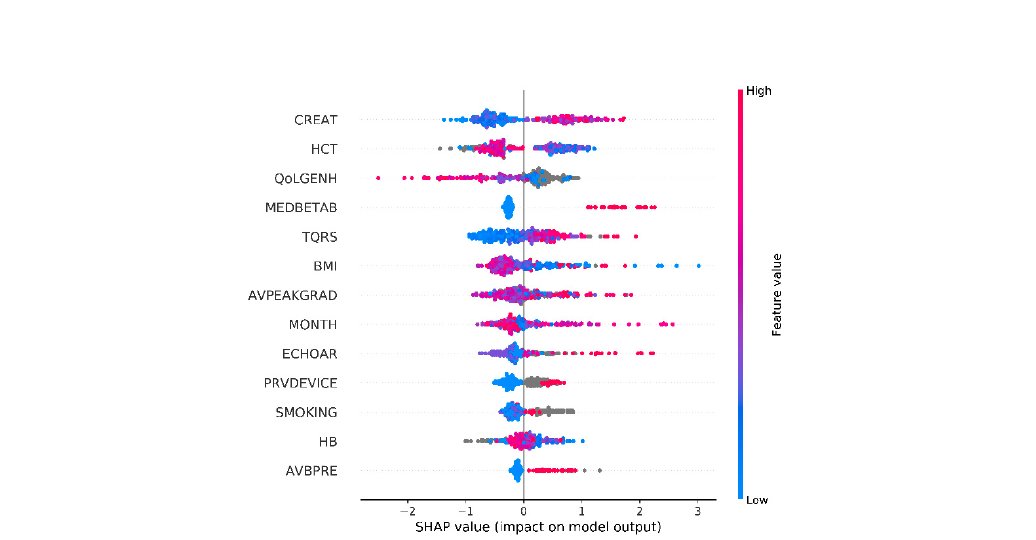
York heart association functional classification (NYHA class), QTC interval, gender, glo ‐ merular filtration rate (GFR), recent coronary artery bypass grafting (CABG) interven ‐ tions, previous myocardial infarction and further classes of medicines e.g., angiotensin ‐ converting ‐ enzyme (ACE) inhibitors, angiotensin II receptor blockers (ARBs), and proton pump inhibitors (PPIs). We emphasize here that several factors are influencing the feature selection and the classifier training. Particularly, the order of the most important features can be highly in ‐ fluenced by the missing values. In fact, a certain feature can ascend or descend the list of the most important features proportionally to the amount of its missing values. It must be said that missing values contain information as well because they are a natural conse ‐ quence of the clinical workflow, of the internal protocols adopted by each hospital, and of the varying urgencies that characterize each patient journey. However, by including all the features shown in Table 3 in the final model, we ensured an optimal overview of the patient, acquired with a multi ‐ disciplinary approach, which has shown promising gener ‐ alization capability on this dataset. 3.2. Evaluation of the Model In Table 6, the performance of the mortality predictor achieved in this work is com ‐ pared to the ones achieved in other studies available in the literature. As previously men ‐ tioned, EuroSCORE II and STS, which are extensively accepted as risk scores by the car ‐ diologist worldwide, reached in a TAVI study AUCs of 0.81 and 0.77, respectively. How ‐ ever, only 59 symptomatic patients with severe aortic stenosis were selected for this 30 ‐ day mortality study [21]. Two prognostic risk scores for one ‐ year mortality prediction for the TAVI procedure are the TAVI2 ‐ SCORe [4] which when validated on 511 patients, showed an AUC of 0.72, and the Arnold SV et al. [5] which when validated on 1830 pa ‐ tients, achieved an AUC of 0.66. Other 30 ‐ day mortality predictors for TAVI which are worth mentioning for comparison as they have been validated on a large population, are the ones presented in the works of Iung et al. [22], Capodanno et al. [23], and Martin et al.